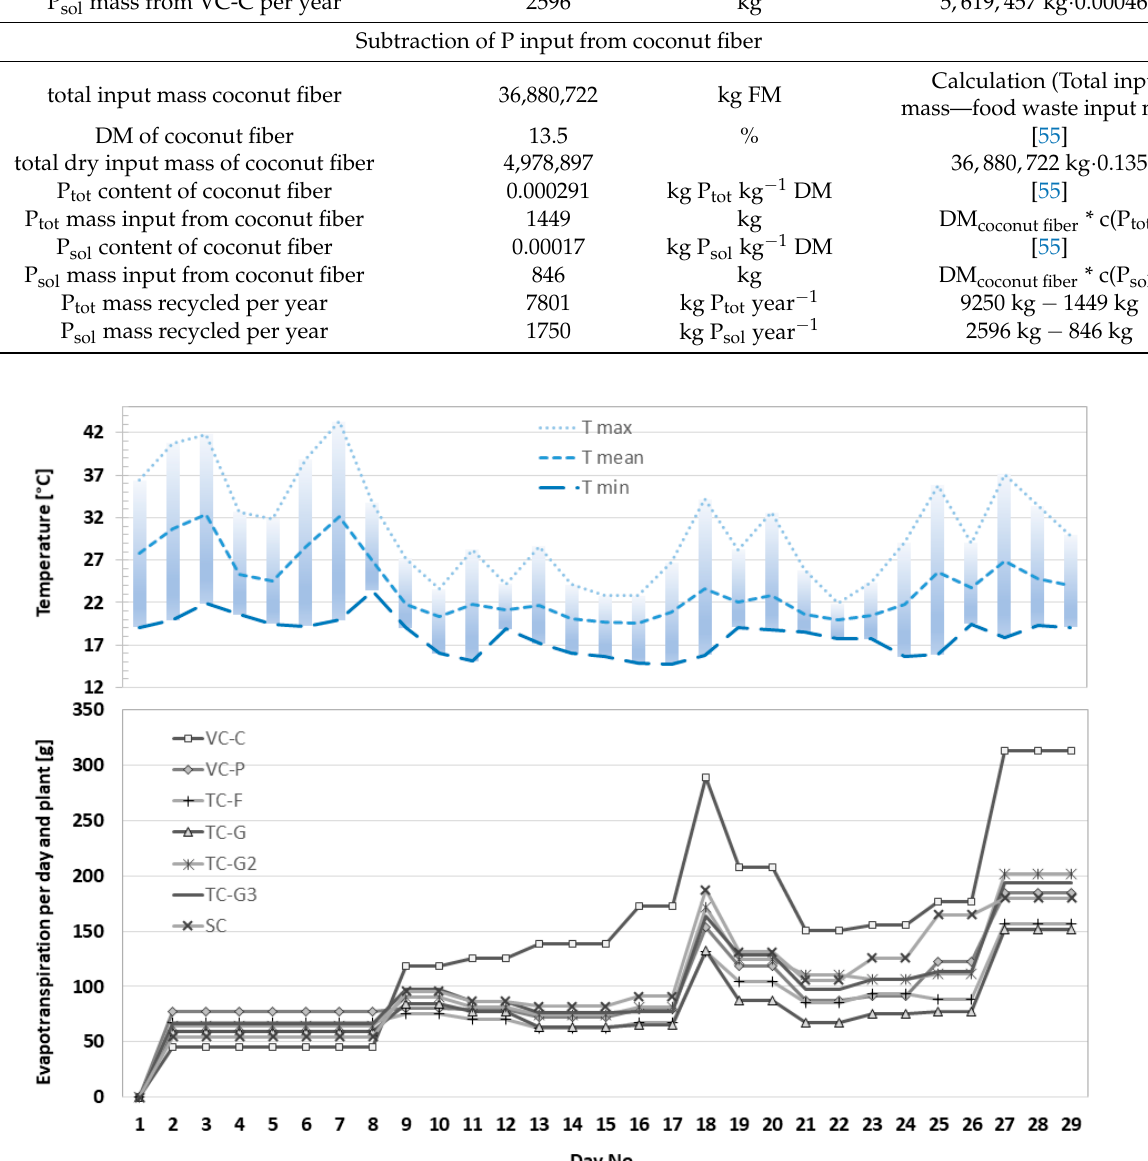
Figure A1. Evapotranspiration of the lettuce plants and climate chamber temperature data. The lower y -axis shows the evapotranspiration of the treatments in g per plant and day for the different treatments (measured and interpolated). The upper y -axis shows the temperature [°C] in the climate chamber during the experiment. The lower and upper lines indicate the daily minimum and the daily maximum temperature. The middle line indicates the daily mean temperature. The average air temperature during the whole experimental period was 26.6 °C at day and 20.7 °C at night, and the average relative humidity was 57.9%.